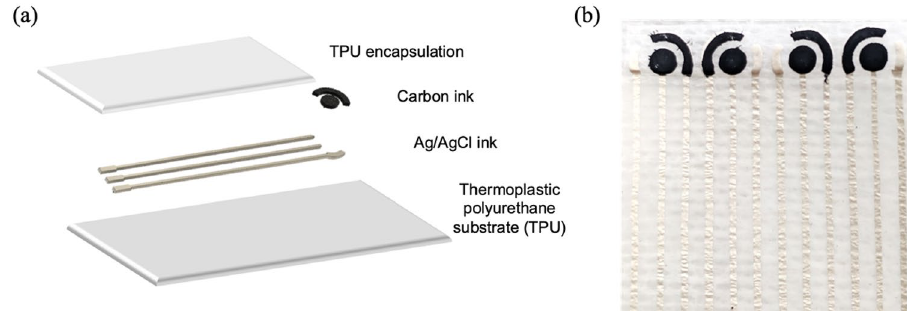
Figure 6. ( a ) Schematic representation of the different layers of the fabricated sensor used for detection of uric acid in chronic wounds. Sensors with and without the final TPU encapsulation were termed as encapsulated and non-encapsulated sensors respectively, ( b ) A photograph illustrating a prototype of a fabricated sensor